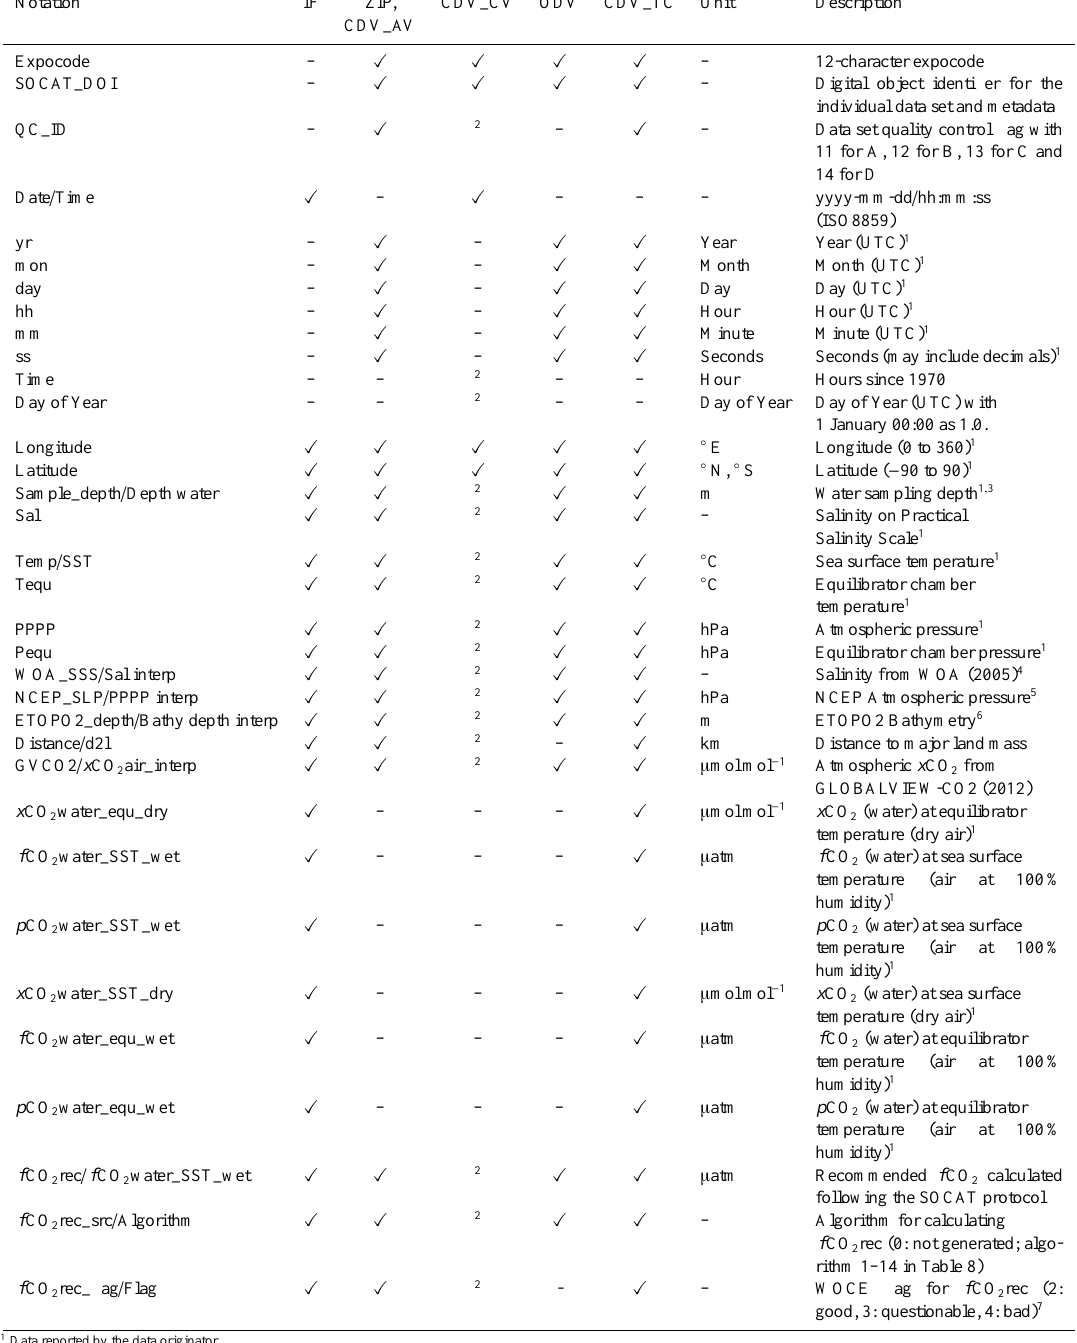
Table 3. Content of the individual data set files (IF) and the synthesis files in SOCAT version 2. The global synthesis product is available as zip text files at CDIAC (ZIP) and in Ocean Data View (ODV) format. Subsets of the global synthesis data set can be created via the Cruise Data Viewer for All Variables (CDV_AV), Current Variable (CDV_CV) and via the Table of Cruises (CDV_TC). The first column (“Notation”) lists column headers for the parameters in the files.